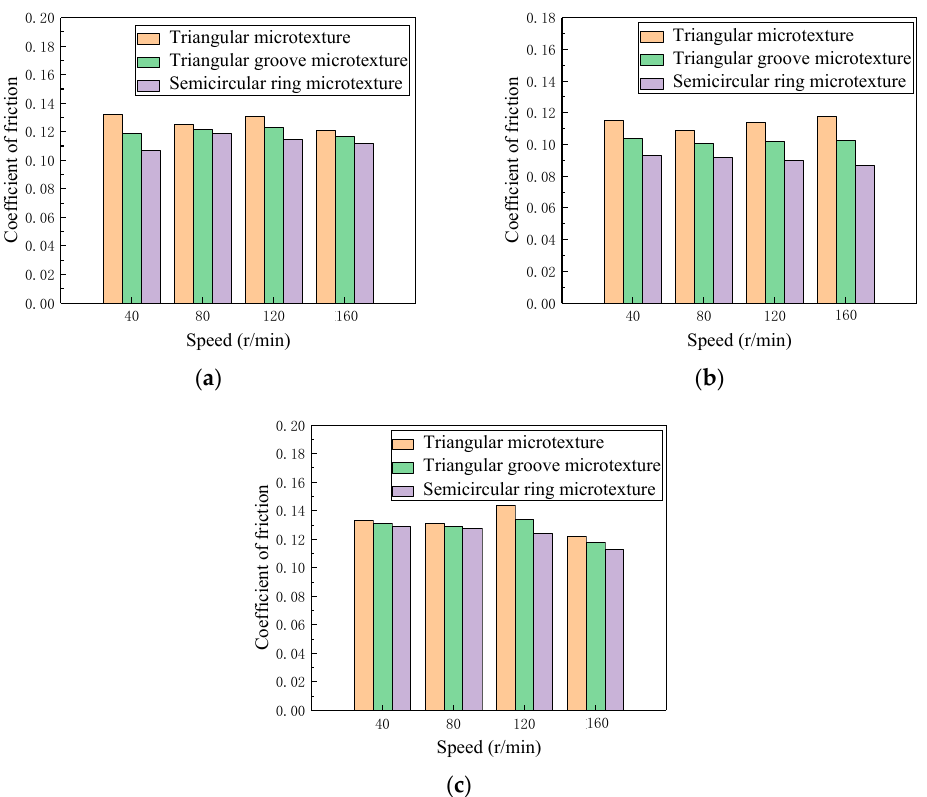
Figure 13. Coefficients of friction of surface with different morphological textures: ( a ) area occupancy ratio of 7%; ( b ) area occupancy ratio of 10%; ( c ) area occupancy ratio of 13%.